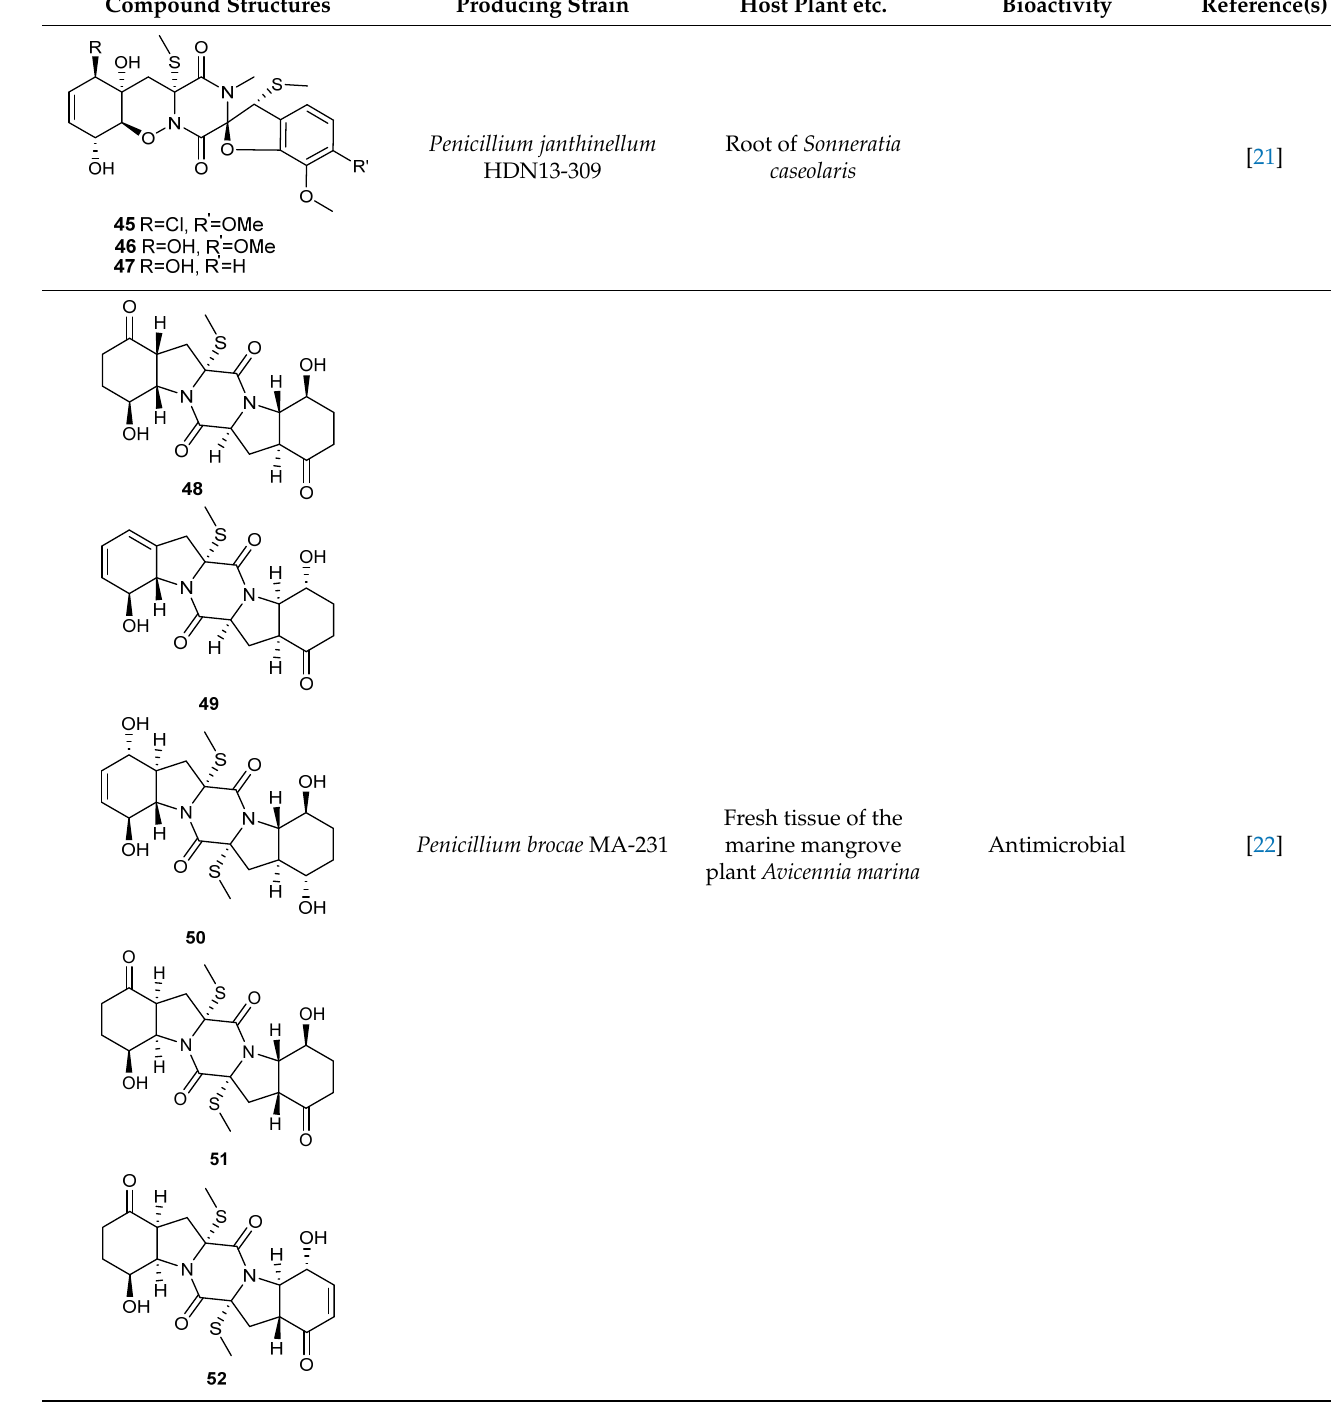
Table 1. Cont . Compound Structures Producing